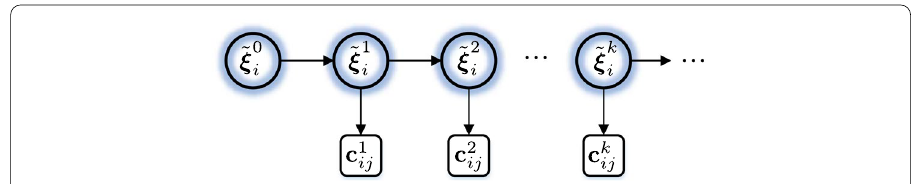
Fig. 7 Bayesian representation of offset and skew